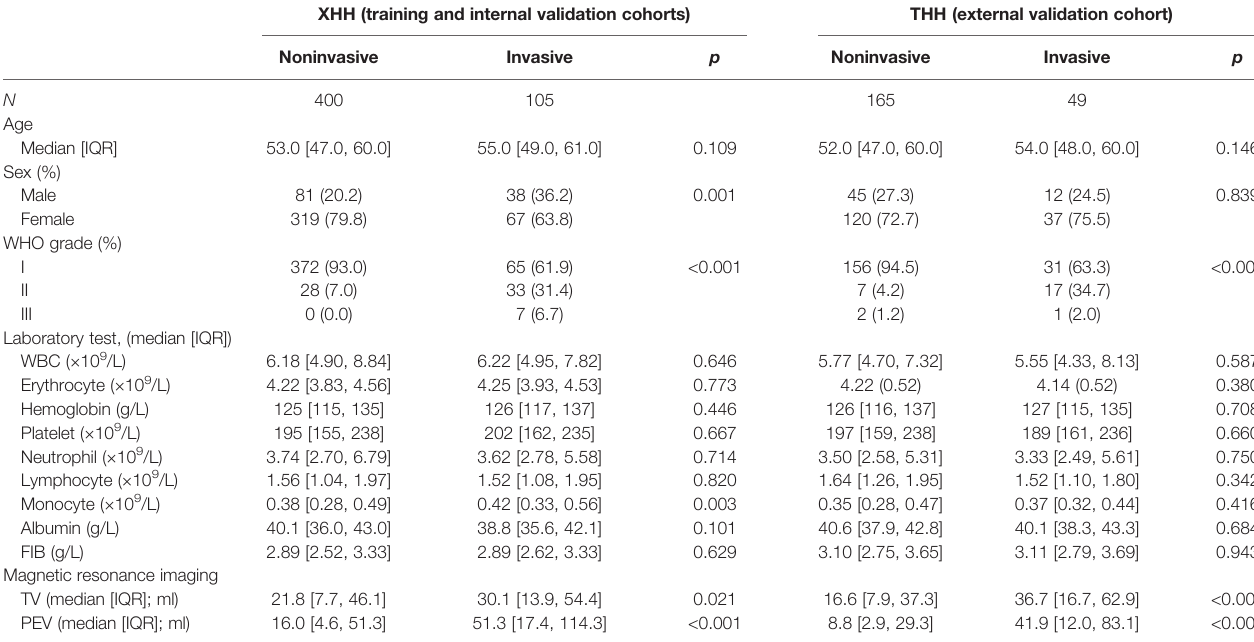
TABLE 1 | Baseline characteristics of the patients in the different cohorts.